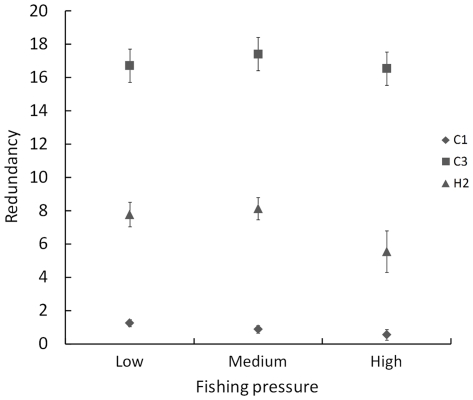
Average redundancy of three functions, for different levels of fishing pressure.Average redundancy of the three functions which showed a significant response to fishing pressure in GLMs (C1, C3 and H2), for each category of fishing pressure. Confidence intervals (95%) are indicated.